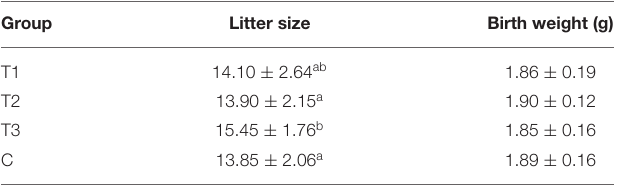
TABLE 4 | The changes of litter size and offspring birth weight in mice immunized with different plasmids. Group